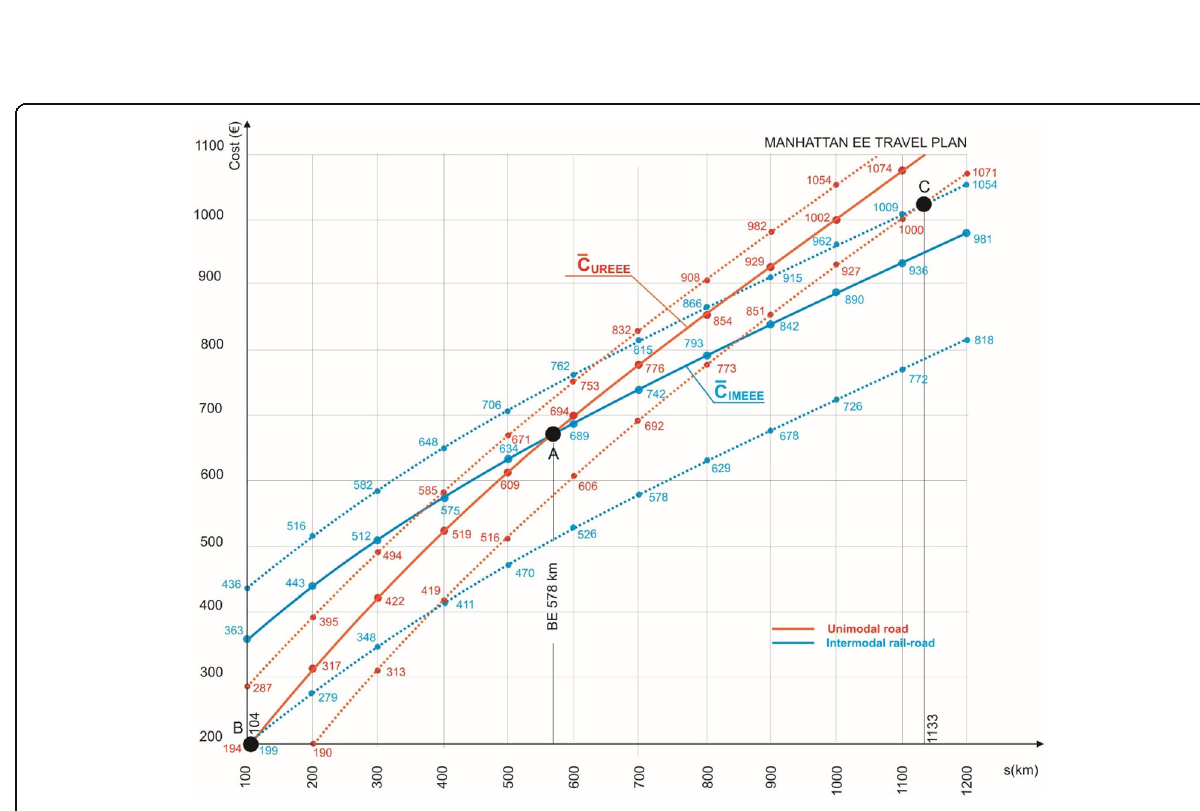
Fig. 8 Cost functions and break-even distances (Manhattan